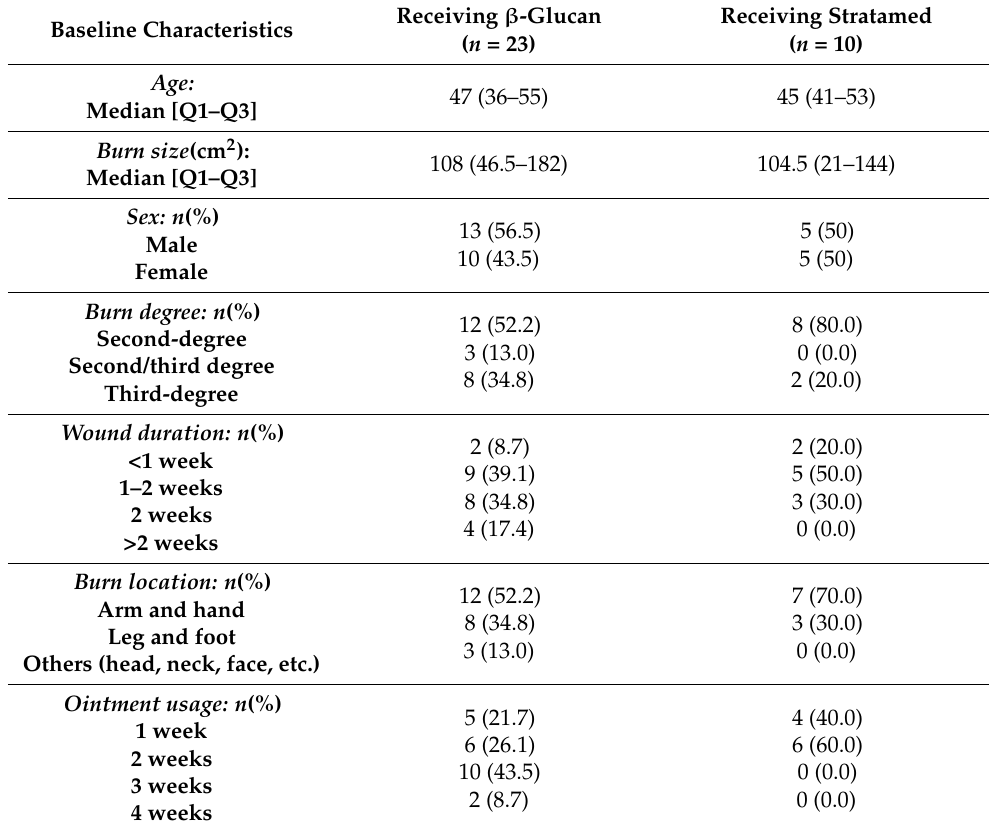
Table 1. Baseline characteristics of the